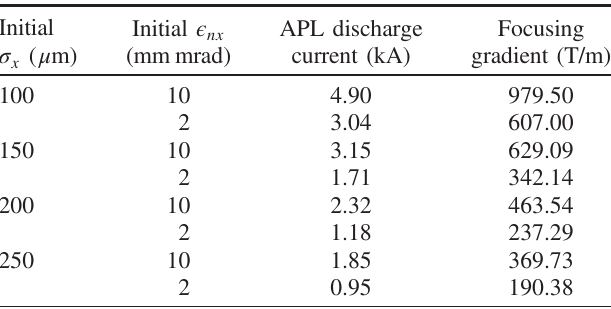
TABLE II. Discharge current and focusing gradient of the APL required for beam size matching at the